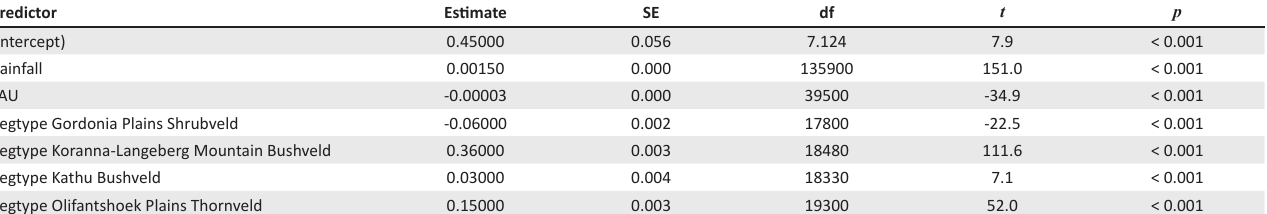
TABLE 1: Results of a linear mixed-effects model that explores the effect of rainfall, large animal units and vegetation type (explanatory variable) on vegetation productivity represented by the small integrated value of Enhanced Vegetation Index (responsive variable) in the Tswalu Kalahari Reserve. The year and id of the pixel are added as random terms in the model.